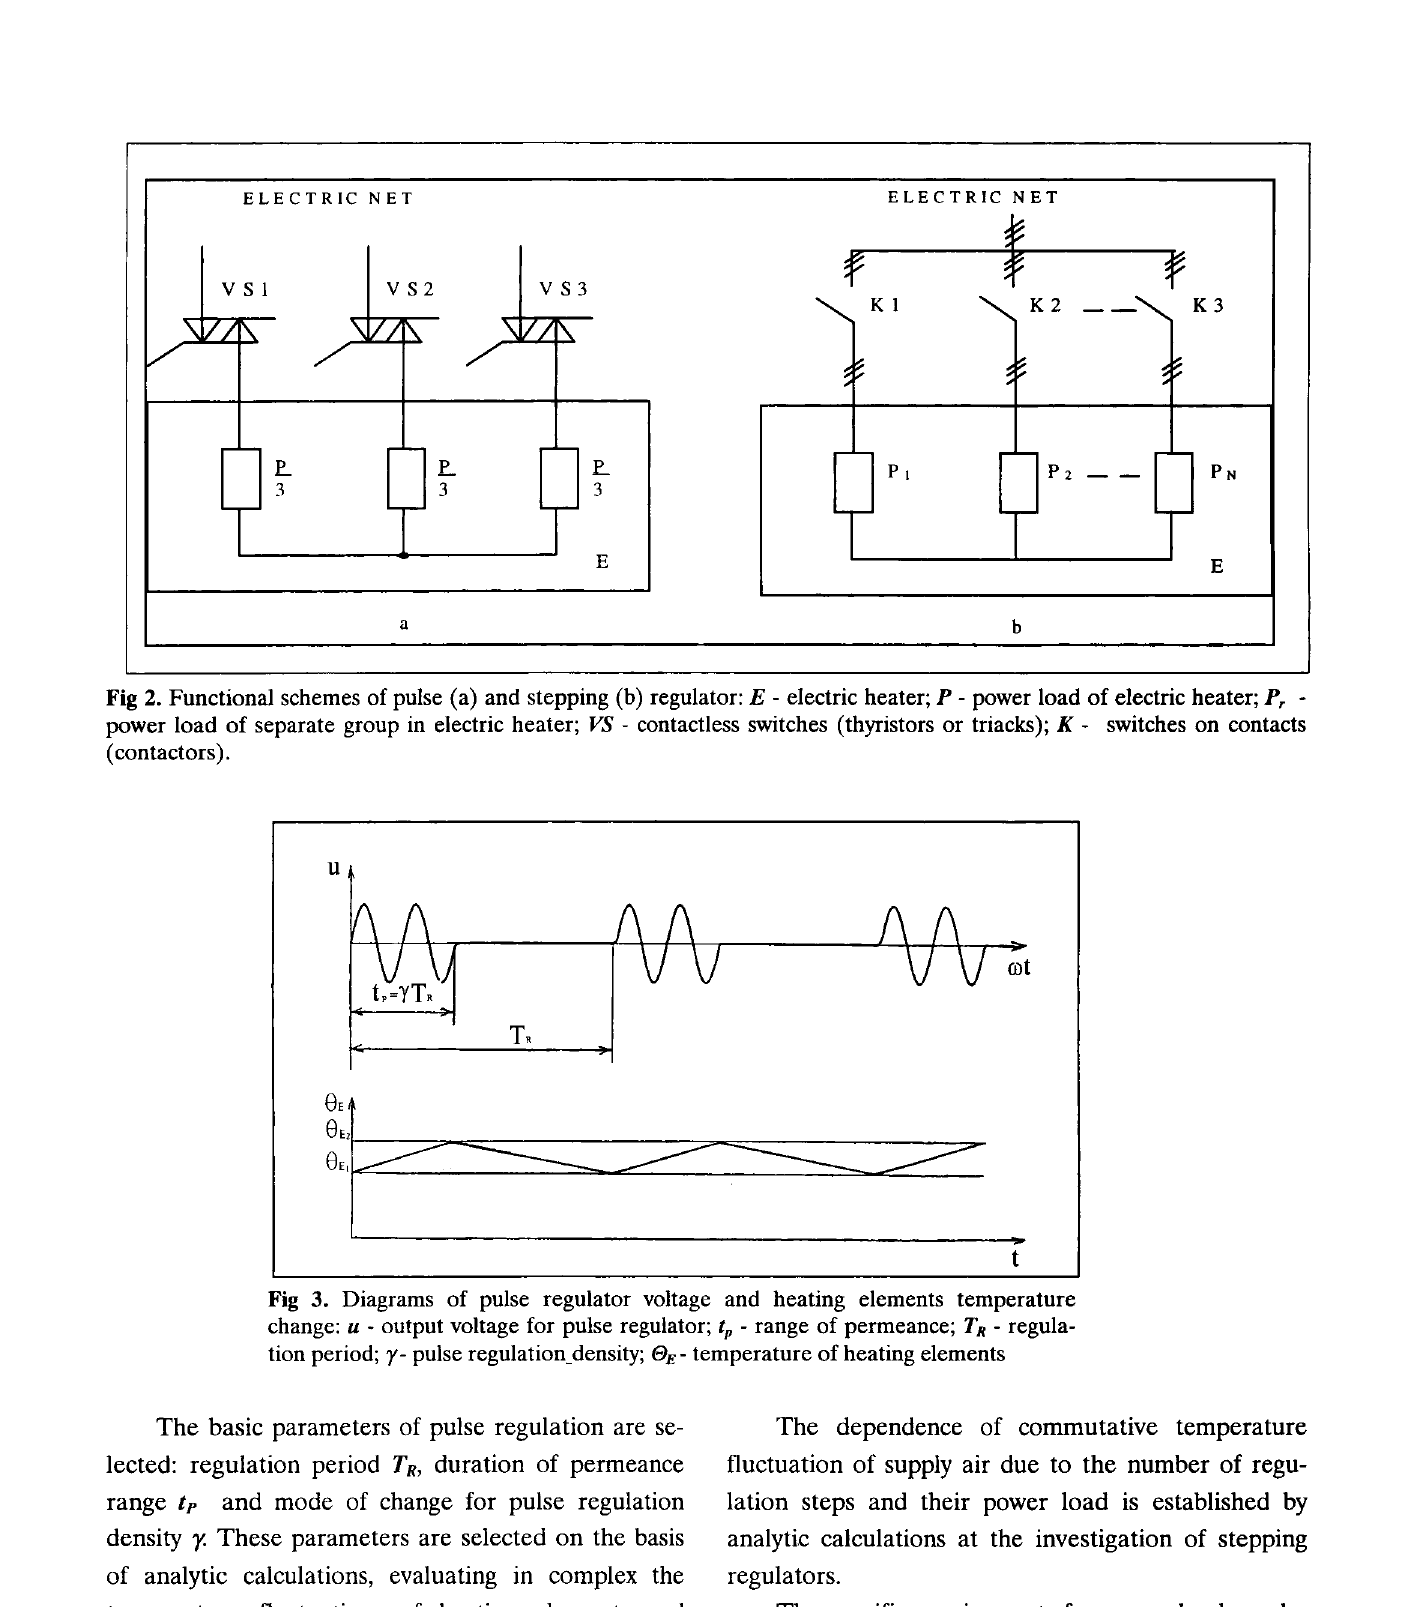
Fig 3. Diagrams of pulse regulator voltage and heating elements temperature change: u - output voltage for pulse regulator; tP - range of permeance; TR - regula tion period; y- pulse regulation_ density; BE- temperature Of heating